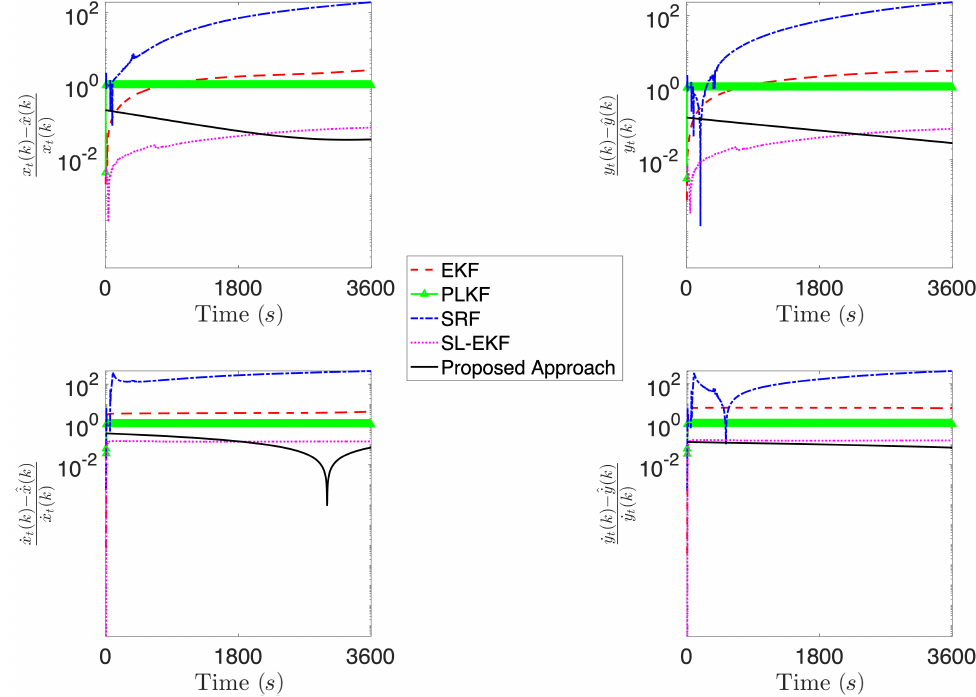
Figure 12. Comparison of the proposed approach against EKF, PLKF, SRF and SL-EKF, considering a scenario where the methods compared with the proposed one are initialized with (cid:98) x 0 | 0 = ψ and Σ = diag ( ψ ) 2 0 | 0